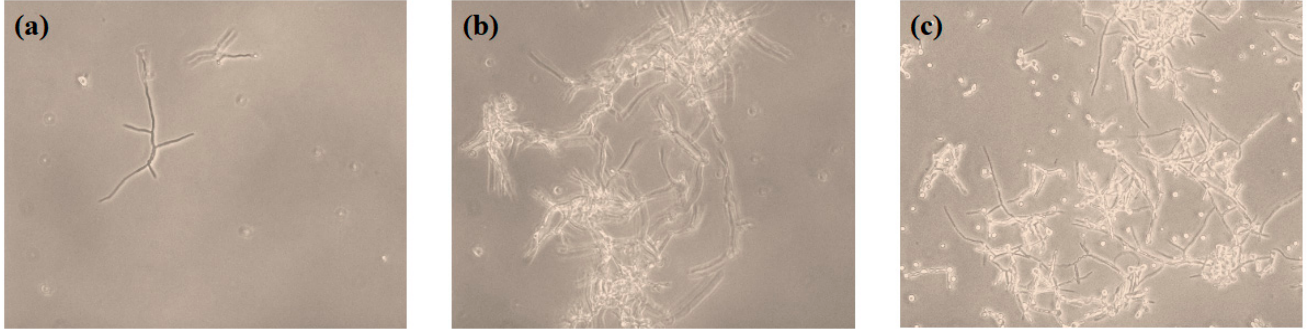
Figure 5. Morphologies of Tolypoclzdium inflatum ATCC 34921 growth. 2 days ( a ), 8 days ( b ), and 12 days ( c ).